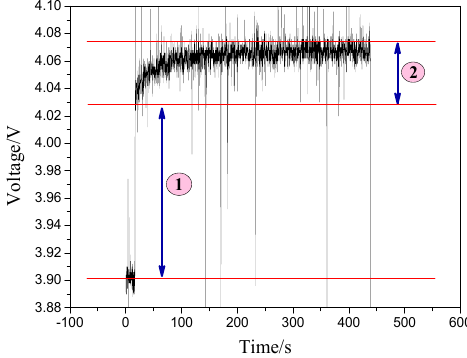
Figure 1. Terminal voltage response at the end of discharge.